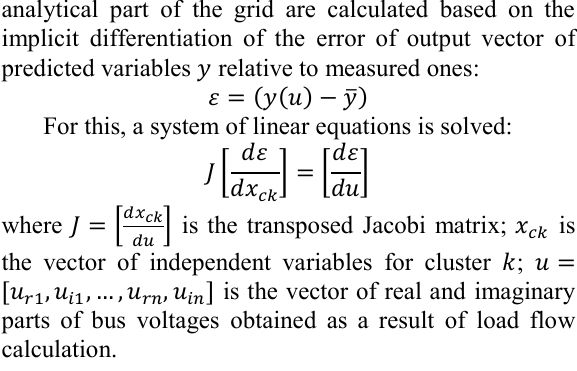
Fig. 11. The result of prediction is insufficient on real sized problem.